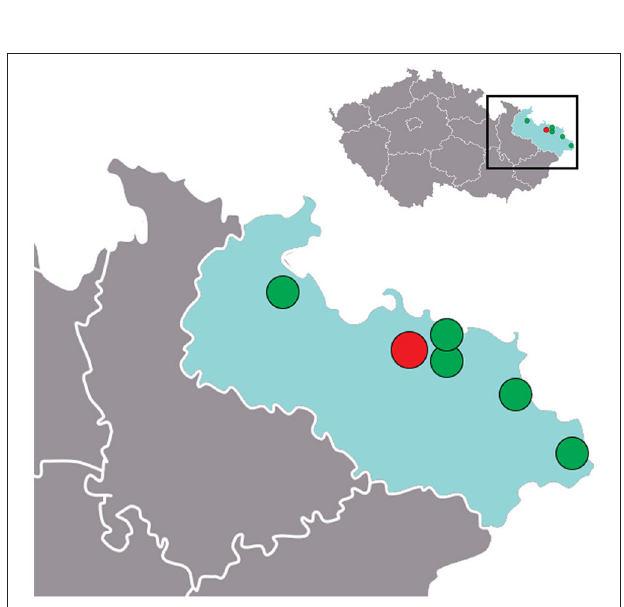
FIGURE 3 | Stroke centers in the Moravian–Silesian region of the Czech Republic (gray color). Green circles, PSC; red circle, CSC.